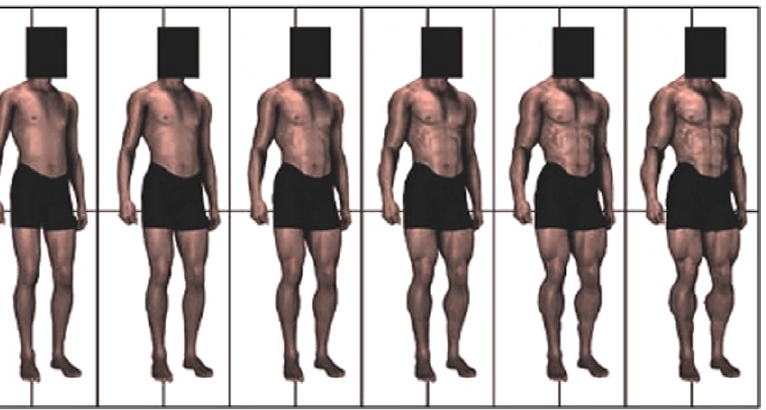
Figure 3. Array used by participants to provide estimates of muscularity of target individual. Modified with permission from Frederick DA, Peplau LA (2007) The UCLA Body Matrices II: Computer-generated images of men and women varying in body fat and muscularity/breast size to assess body satisfaction and preferences. 8TH Annual Meeting of the Society for Personality and Social Psychology. doi:10.1371/journal.pone.0032751.g003 PLoS ONE |